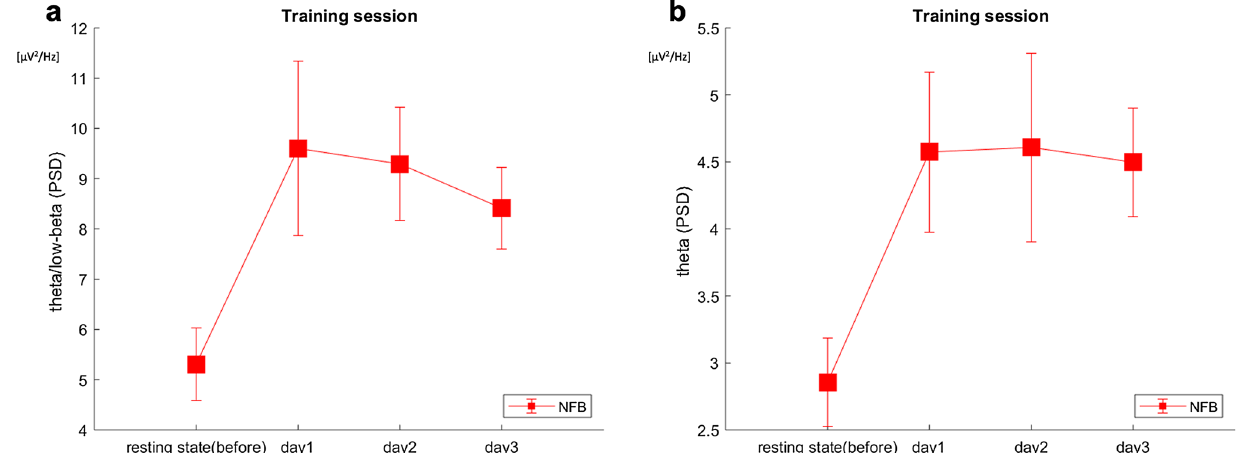
Figure 2. Average brain activities during neurofeedback training sessions. ( a ) The average theta/low-beta power spectral density (PSD) during the resting state and the training sessions during neurofeedback (NFB) training. ( b ) The average theta PSD during the resting state and the training sessions during NFB training. The error bars represent ± 1 standard error of the mean. This figure was drawn using MATLAB